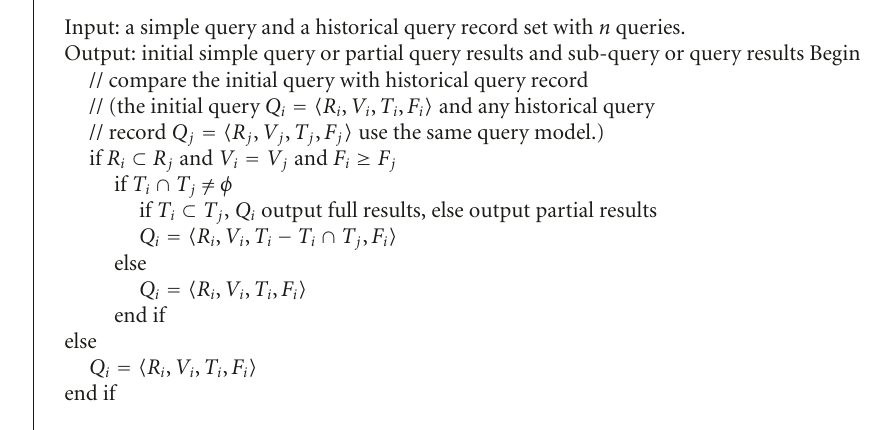
Algorithm 1: Query historical database.